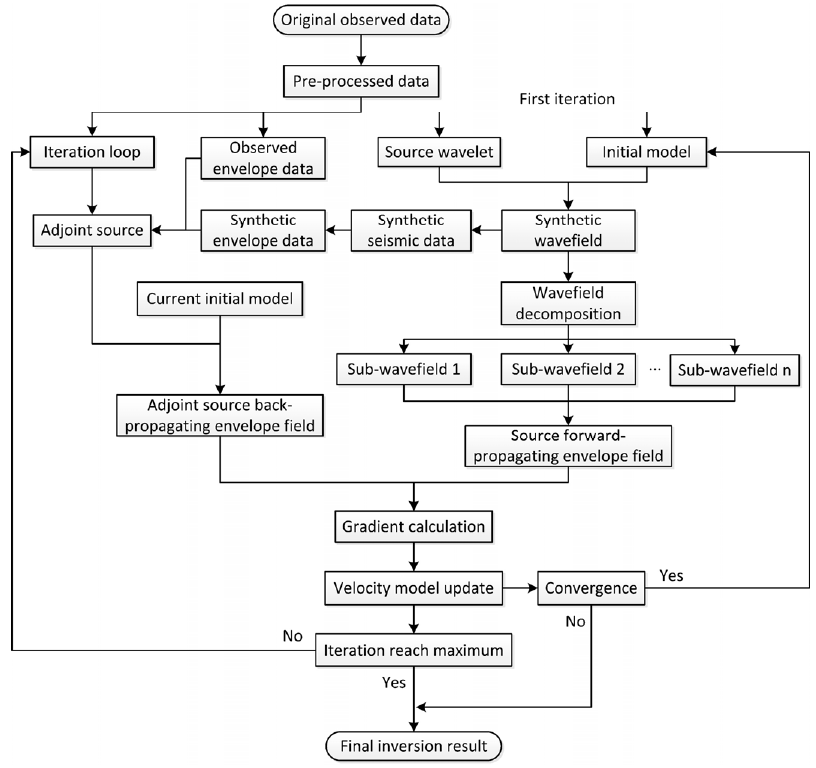
Figure 2. The workflow of the proposed WDDEI method.